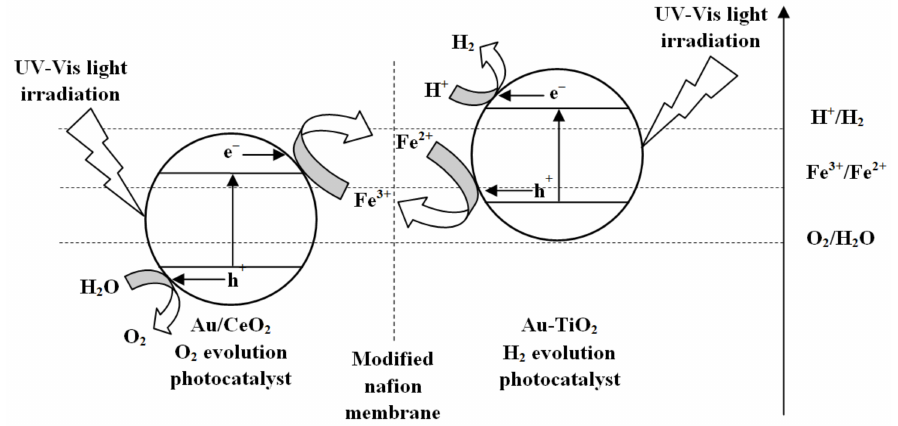
Figure 4. Diagram of the Z-scheme overall water splitting using Au/CeO 2 as a photocatalyst for oxygen generation, Au/TiO 2 for hydrogen generation, and Fe 3+ /Fe 2+ as a redox couple